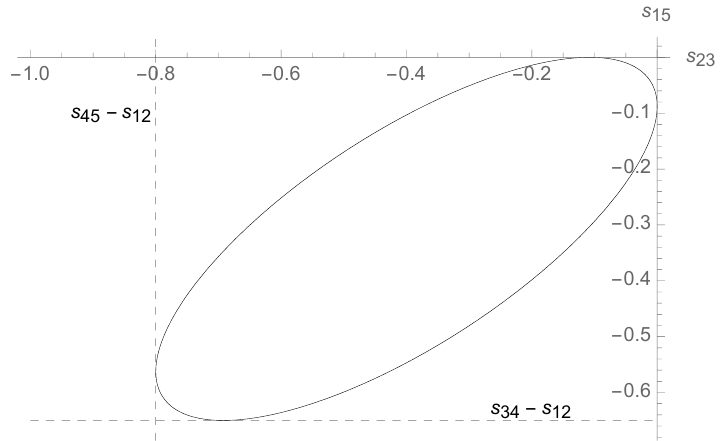
Figure 1 . Kinematical region in the s 12 -channel in the ( s 23 ; s 15 )-plane for s 12 = 1 : 0, s 34 = 0 : 35, s 45 = 0 : 2